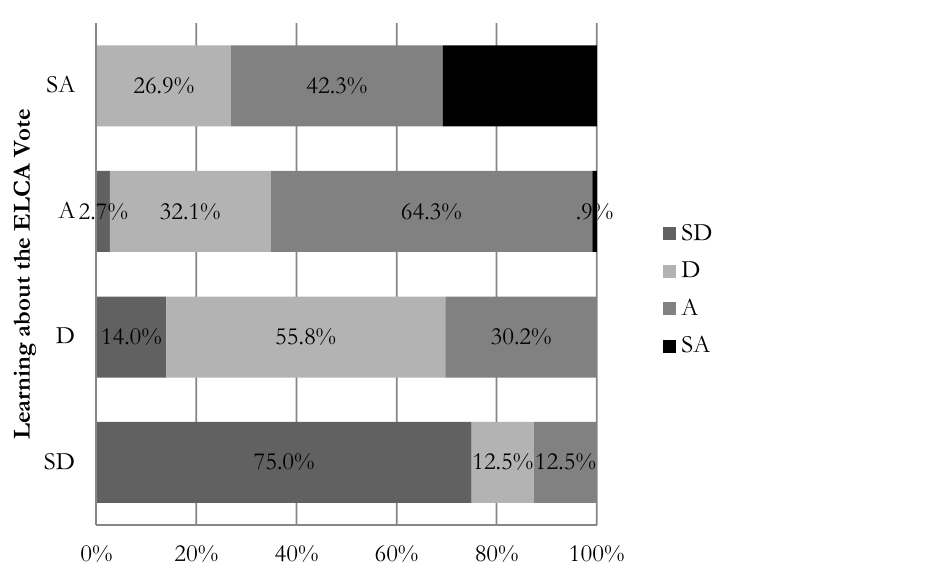
Figure 6 : Whether Meeting Participants Learned about Each Other and their Differences (columns) by Whether they Learned about the ELCA Vote (row